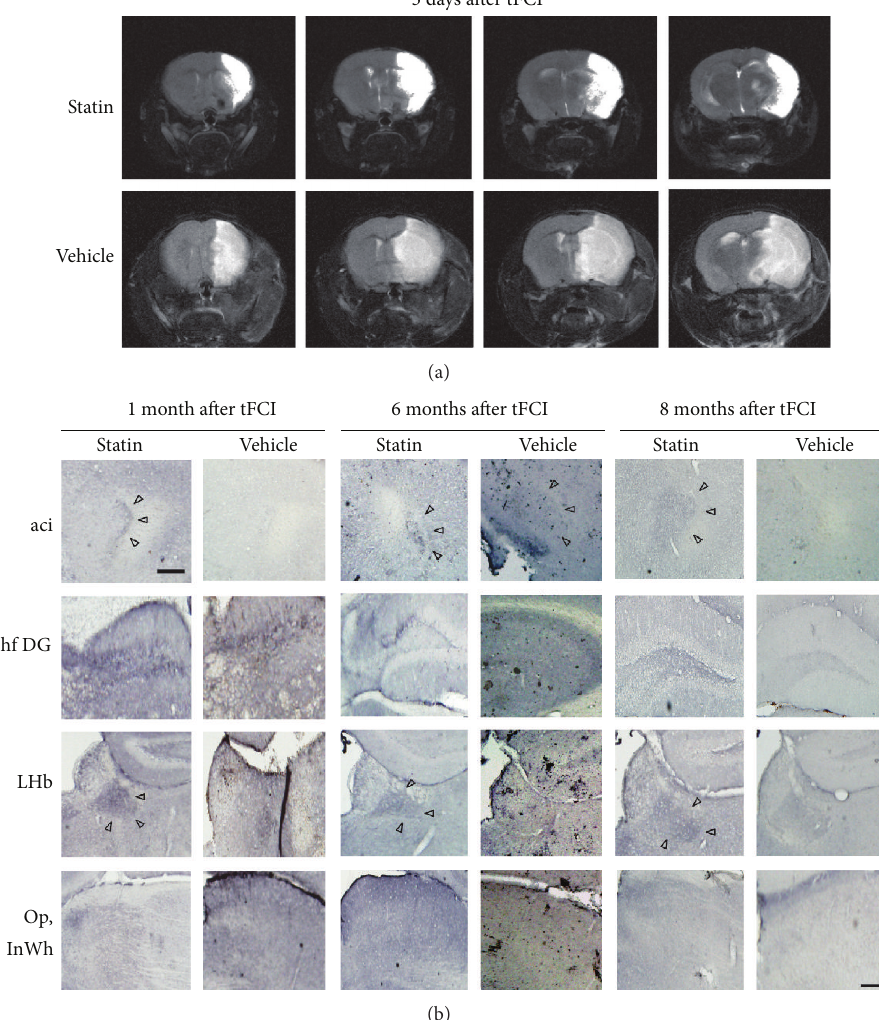
Figure 2: Immunoreactivity of WGA in the tFCI mouse brain. WGA immunoreactivity at 30, 180, and 240 days after tFCI in the vehicle- and atorvastatin-treated groups showed that NA circuitry in the atorvastatin-treated group recovered faster than in the vehicle-treated group at 180 days. aci: anterior commissure, intrabulbar part; hf DG: hippocampal fissure and dentate gyrus; LHb: lateral habenular nucleus; Op: optic nerve layer of the superior colliculus; InWh: intermediate gray layer of the superior colliculus. Scale bar = 500 𝜇